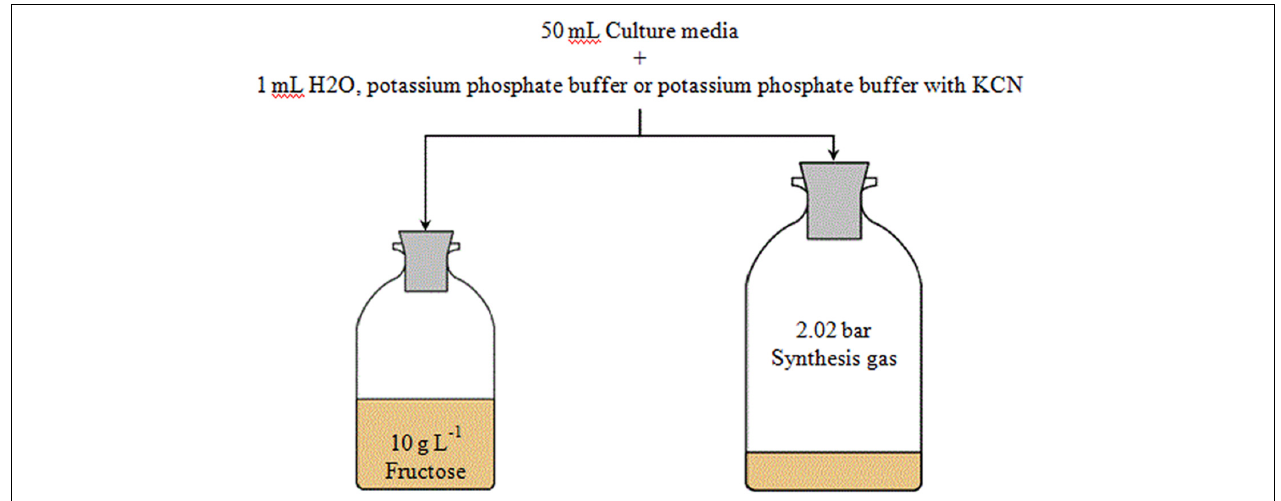
FIGURE 1 | Overview of cyanide experiments with C. ljungdahlii . Effects of cyanide are investigated in both fructose and syngas growing cultures with cyanide concentrations of 0, 0.025, 0.05, 0.1, and 1.0 mmol L − 1 . Experiments are conducted in triplicates.